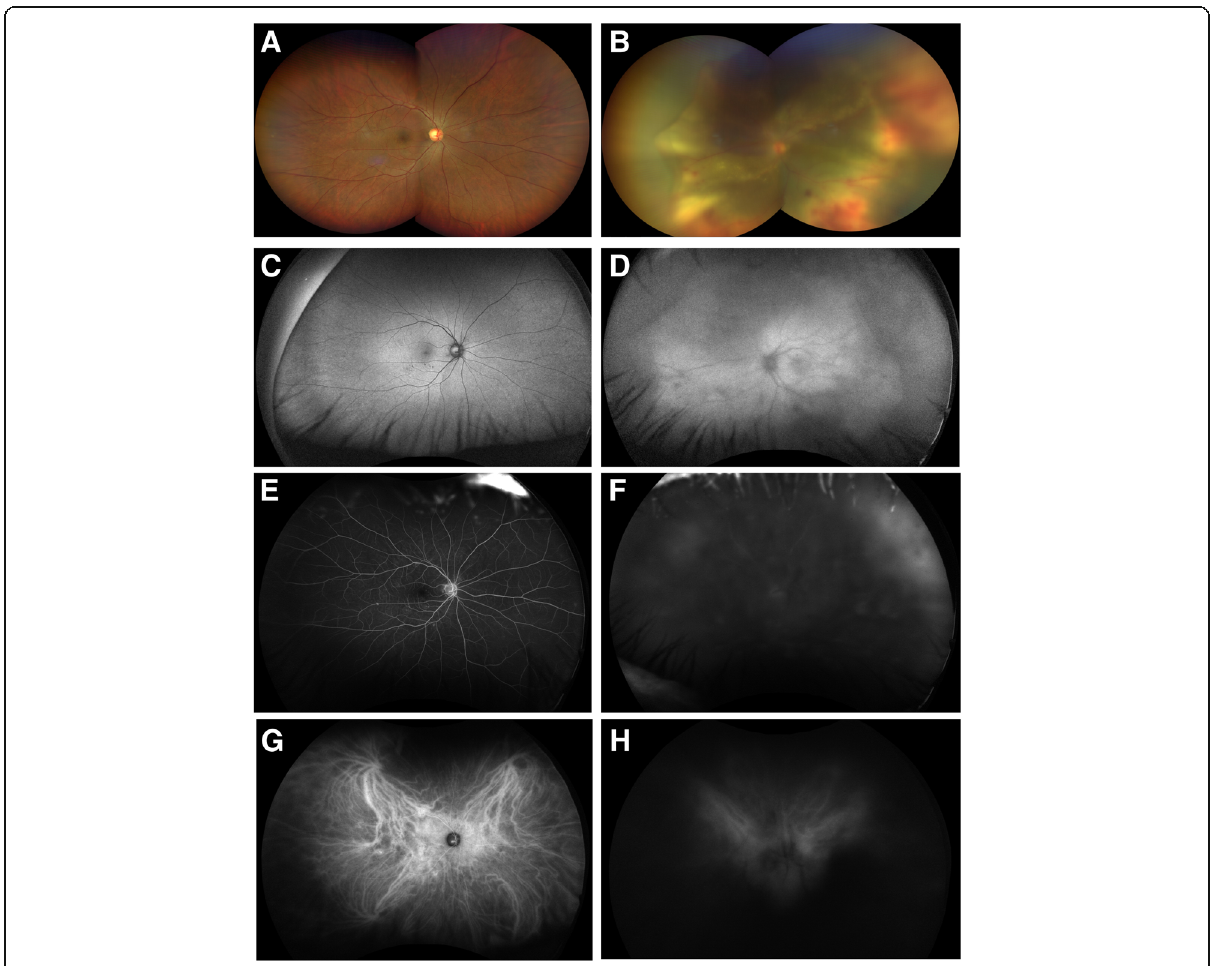
Fig. 1 Fundus photographs, fundus autofluorescence, fluorescein angiography, and indocyanine green angiography of both eyes. Fundus photograph of the right eye was within normal limits, while the left eye demonstrated 4+ vitreous cell as well as dense vitreous haze with intraretinal submacular hemorrhage and exudative retinitis ( a , b ). Fundus autofluorescence demonstrated a normal right eye and hazy view with large patches of hyperautofluorescence of the left eye ( c , d ). Fluorescein angiography and indocyanine green of the right eye were normal, while the left eye demonstrated a hazy view with late peripheral hyperfluorescence/hypercyanescence ( e – h